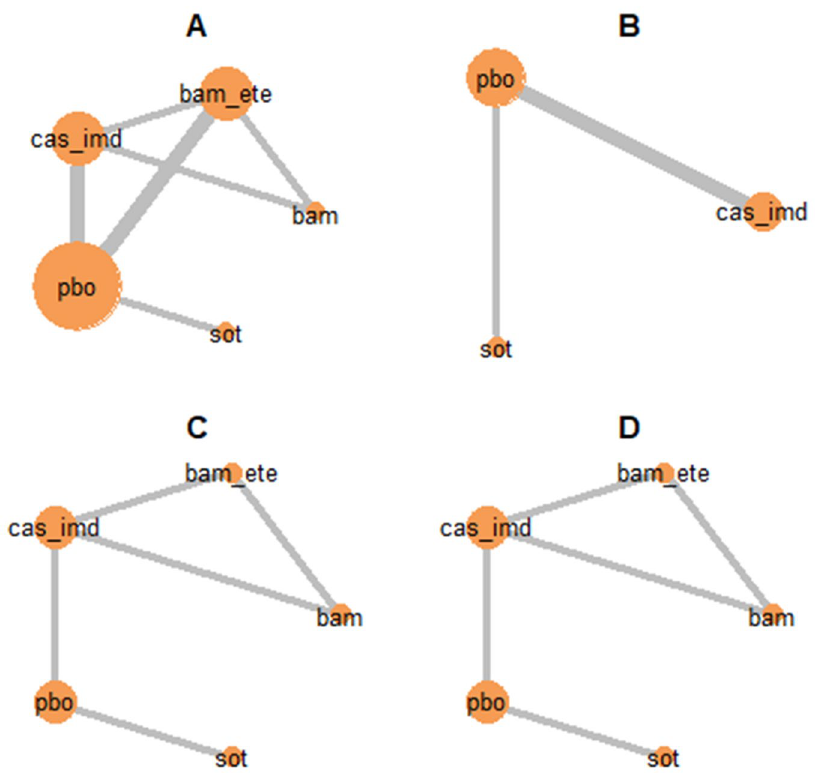
Figure 2. Network diagrams for the outcome-specific NMAs: mortality ( A ), hospitalisation ( A ), invasive ventilation ( B ), ICU admission ( B ), infusion-related AEs ( C ), and serious AEs ( D ). Notation: pbo, placebo; bam, bamlanivimab; bam_ete; bamlanivimab/etesevimab; cas_imd, casirivimab/imdevimab; sot, sotrovimab. A line joining two nodes indicates that there is RCT evidence comparing the corresponding treatments for the relevant outcome. The thickness of each line is proportional to the number of RCTs providing evidence on this comparison (in practice this is either one or two studies for each